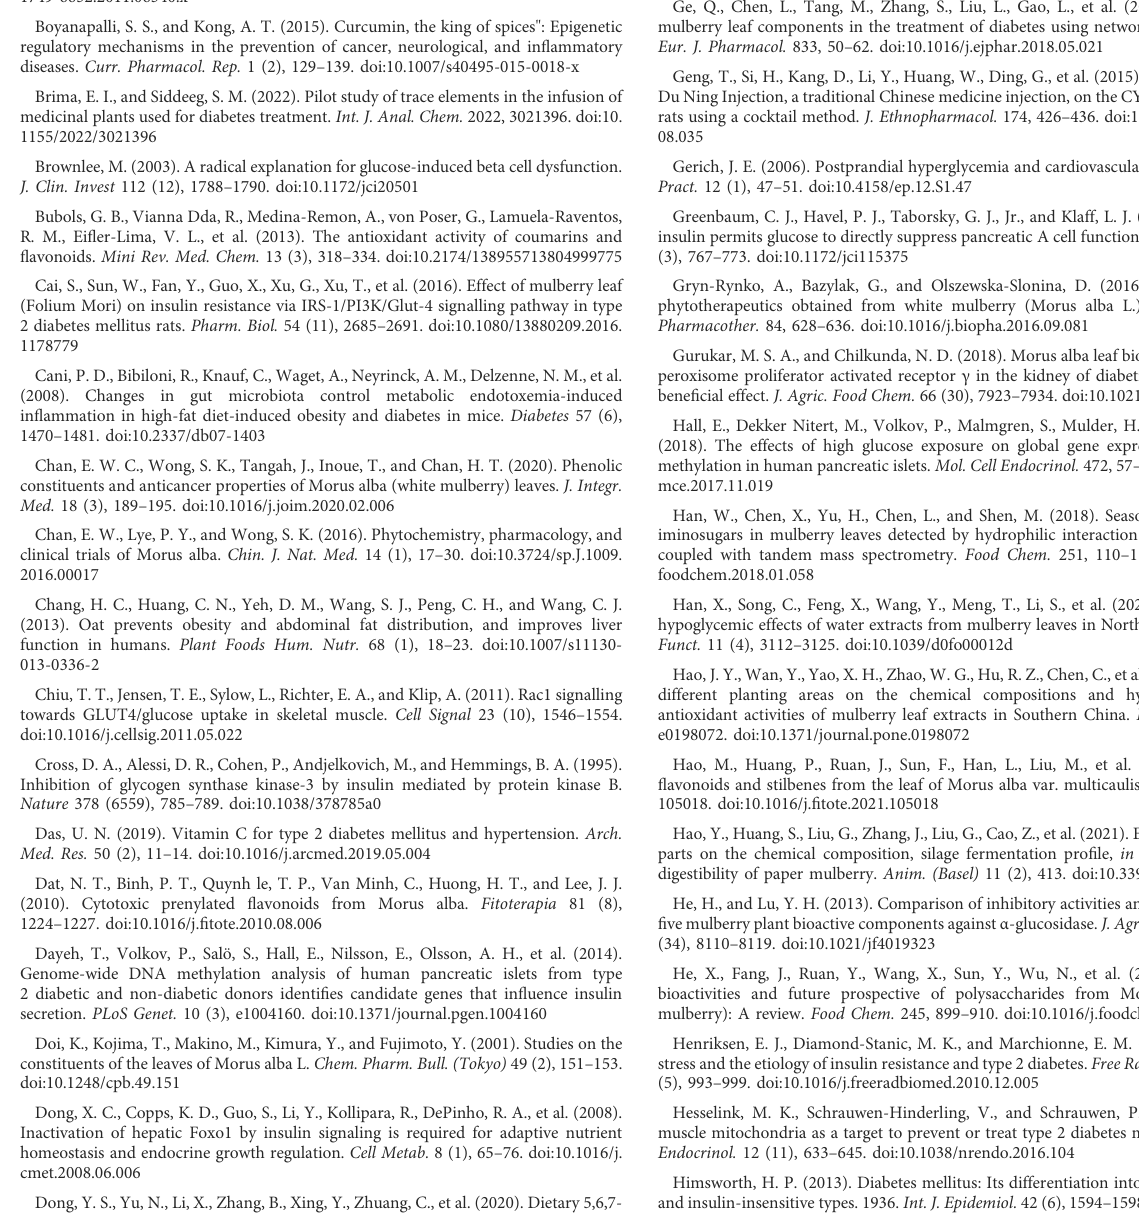
recombinant maltase-glucoamylase subunit of α -glucosidase and lower postprandial blood glucose. J. Agric. Food Chem. 68 (33), 8774 – 8787. doi:10.1021/acs.jafc.0c01668 Du, Y., Li, D. X., Lu, D. Y., Zhang, R., Zheng, X. X., Xu, B. J., et al. (2022). Morus alba L. water extract changes gut microbiota and fecal metabolomein mice induced byhigh- fat and high-sucrose diet plus low-dose streptozotocin. Phytother. Res. 36 (3), 1241 – 1257. doi:10.1002/ptr.7343 Fang, H., and Judd, R. L. (2018). Adiponectin regulation and function. Compr. Physiol. 8 (3), 1031 – 1063. doi:10.1002/cphy.c170046 Figueredo, K. C., Guex, C. G., Reginato, F. Z., Haas da Silva, A. R., Cassanego, G. B., Lhamas, C. L., et al. (2018). Safety assessment of Morus nigra L. leaves: Acute and subacute oral toxicity studies in Wistar rats. J. Ethnopharmacol. 224, 290 – 296. doi:10. 1016/j.jep.2018.05.013 Fukuda, S., and Ohno, H. (2014). Gut microbiome and metabolic diseases. Semin. Immunopathol. 36 (1), 103 – 114. doi:10.1007/s00281-013-0399-z Fullerton, M. D., Galic, S., Marcinko, K., Sikkema, S., Pulinilkunnil, T., Chen, Z. P., et al. (2013). Single phosphorylation sites in Acc1 and Acc2 regulate lipid